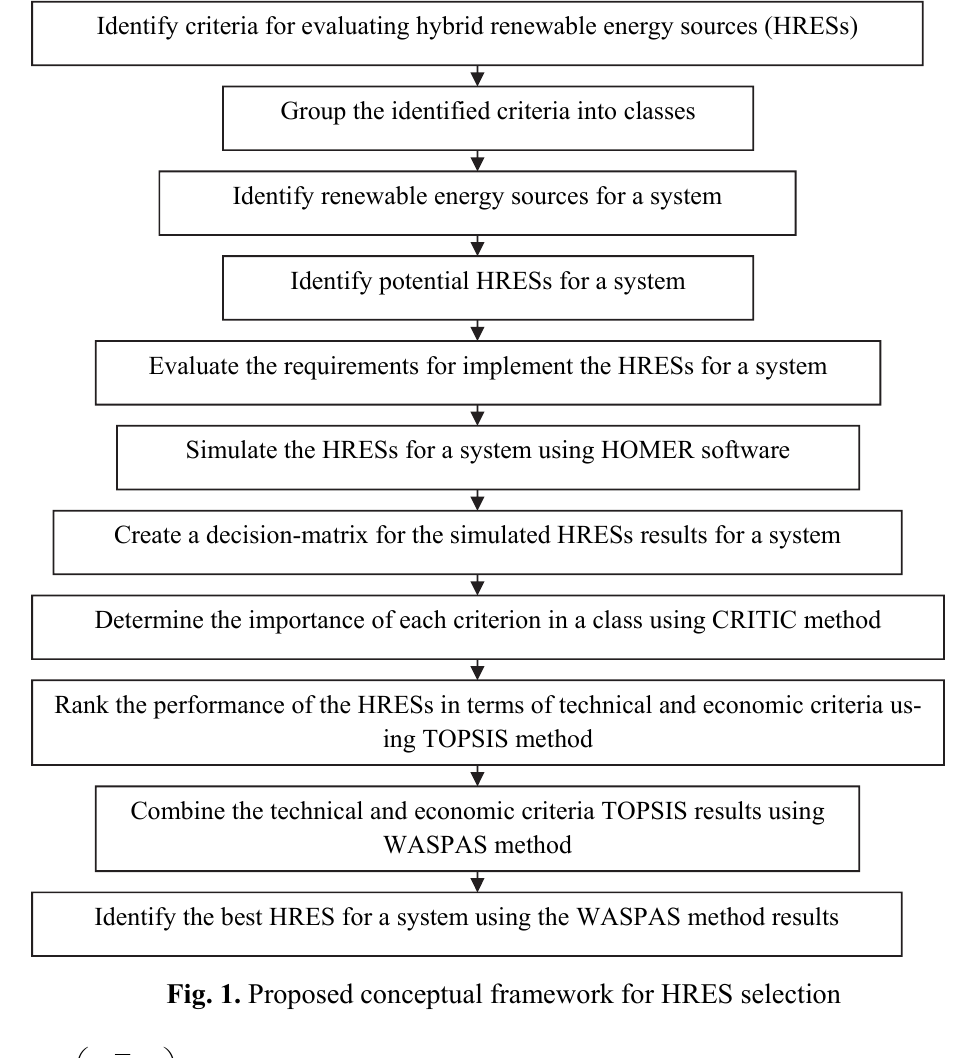
Fig. 1. Proposed conceptual framework for HRES